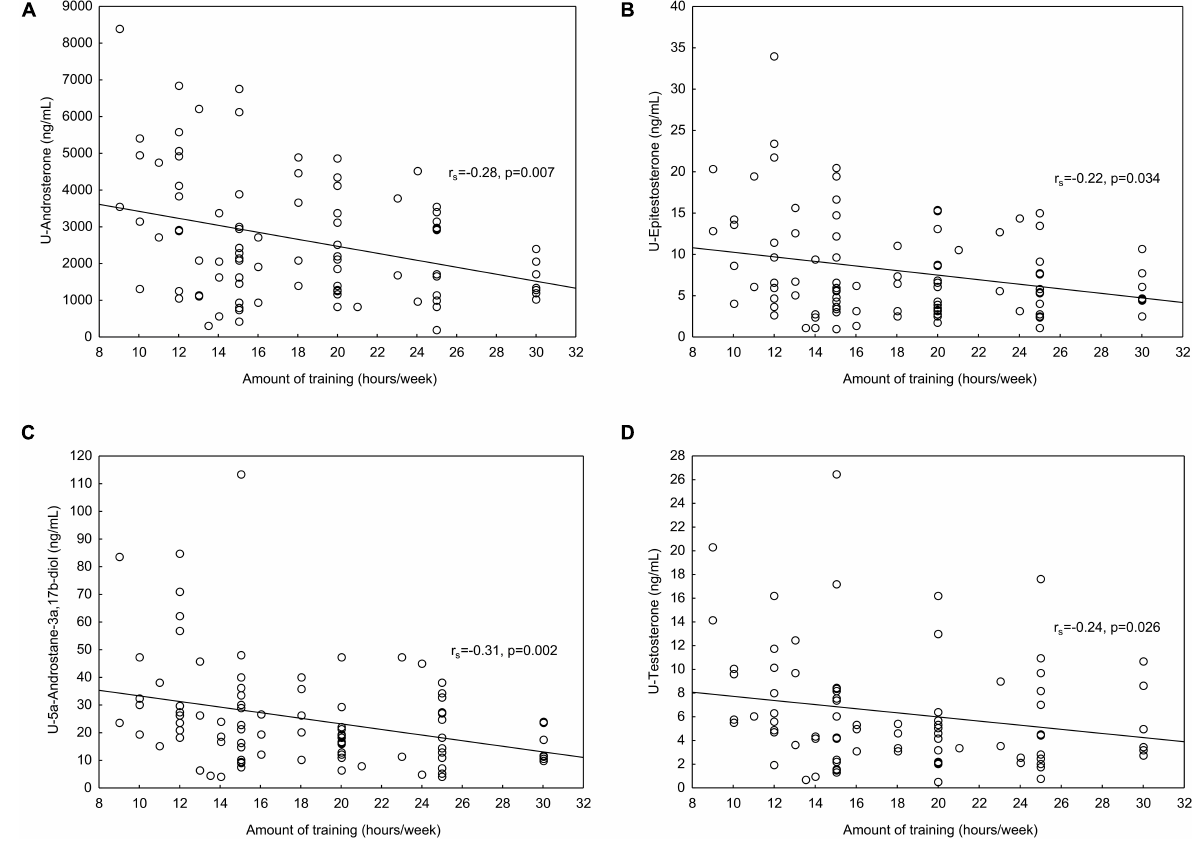
FIGURE 1 | (A) In the athletes, significant negative correlations were found between amount of training (hours/week) and (A) U-Androsterone, (B) U-Epitestosterone, (C) U-5 α Adiol (U-5 α -Androstane-3 α ,17 β -diol) and (D) U-testosterone. In the U-testosterone correlations, UGT2B17 del/del individuals ( n = 9) were excluded from the